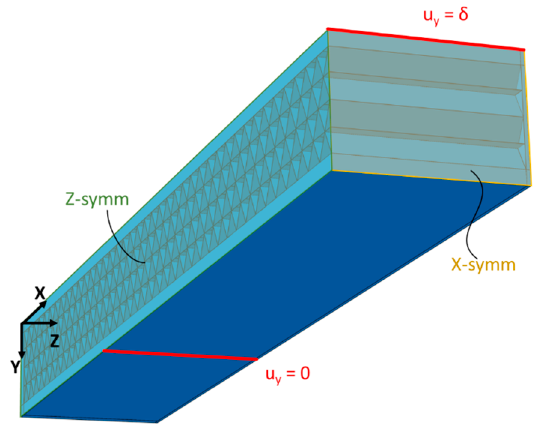
Figure 5. Three-dimensional 3PB simulation for the T45 core with a 160 mm span length. δ refers to the applied displacement reported in Table 2 for the different simulations.